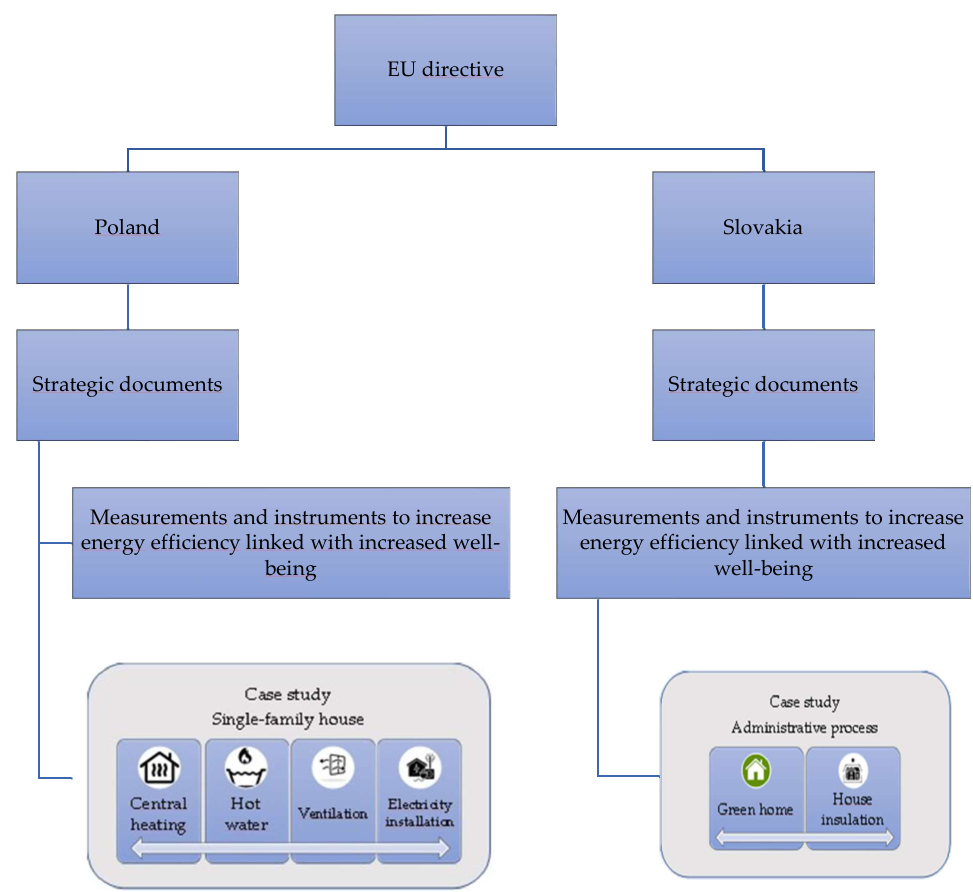
Figure 1. Research